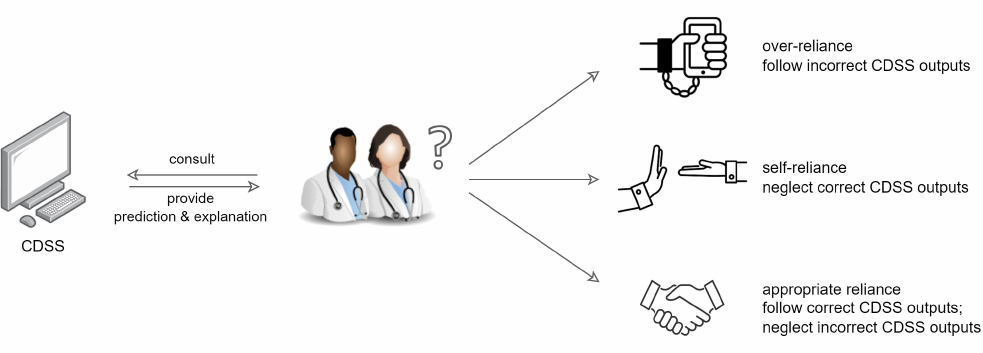
Figure 1. Interaction between healthcare practitioners and a CDSS, classified into over-reliance, self-reliance, and appropriate